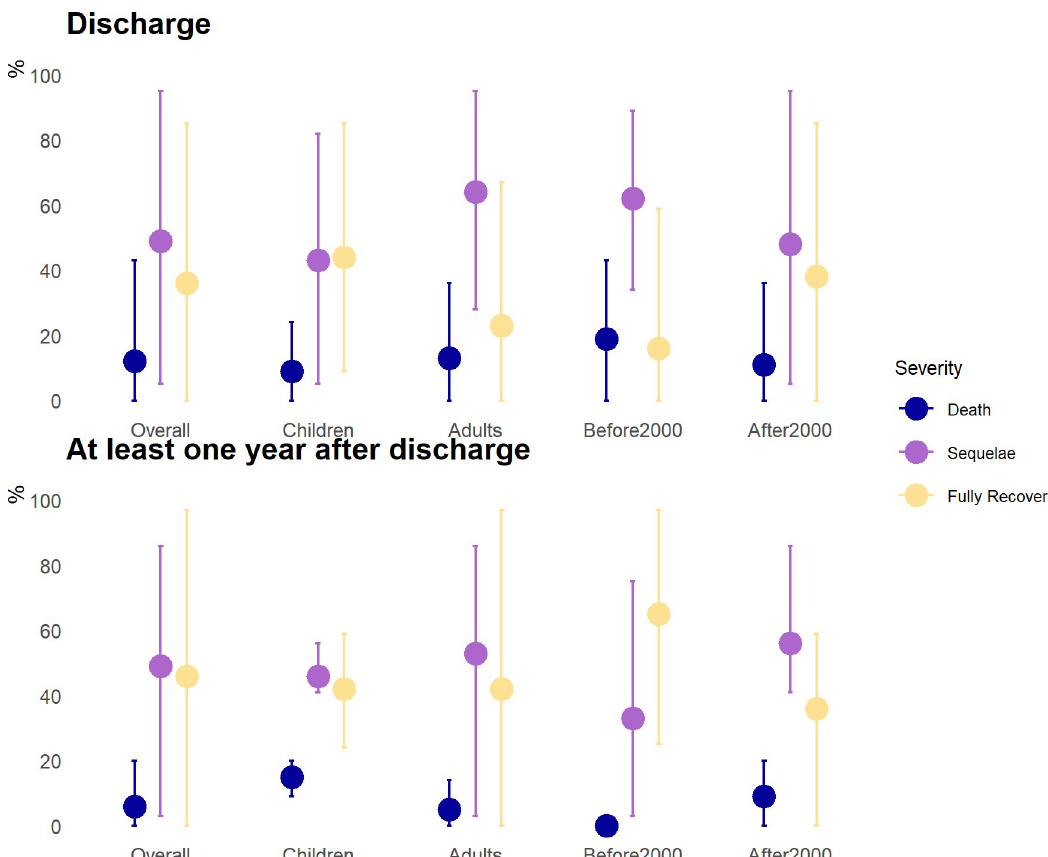
Fig 6. Japanese encephalitis (JE) disease outcomes by age and measurement time. Disease outcomes are stratified by measured at hospital discharge and at least one year after hospital discharge and four subgroups: JE cases before 2000, cases after 2000, adults (JE patients older than 18 years old), and children (JE patients 18 years old and younger). Note that JE death measured at hospital discharge occur at the acute stage of JE infection, while JE death measured at least one year after hospital discharge only contains death occurred during follow